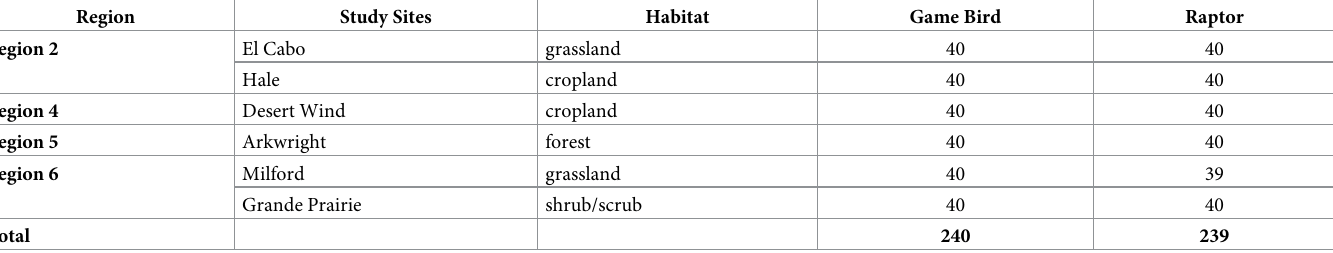
Table 2. Number of carcass persistence trial carcasses concurrently placed in each USFWS region, study site, and habitat type during June 2020 –August 2021 field trials for our study. Region Study Sites Habitat Game Bird